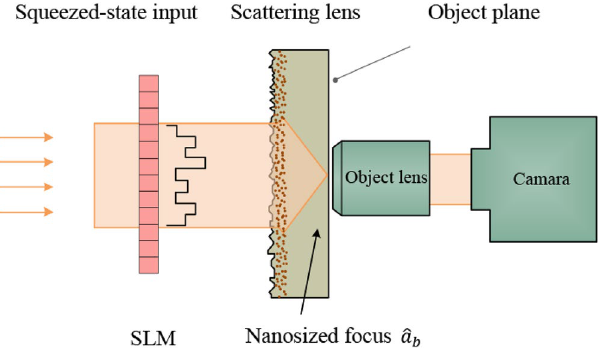
Figure 1. Sketch of optical imaging scheme utilizing a scattering lens with the squeezed-state input. A scattering lens focuses a wavefront-shaped beam [modulated by the spatial light modulator (SLM)] on a small volume. The focus precisely illuminates a small object in the object plane. By scanning the focus and collecting the light behind the object, the image of the object can be